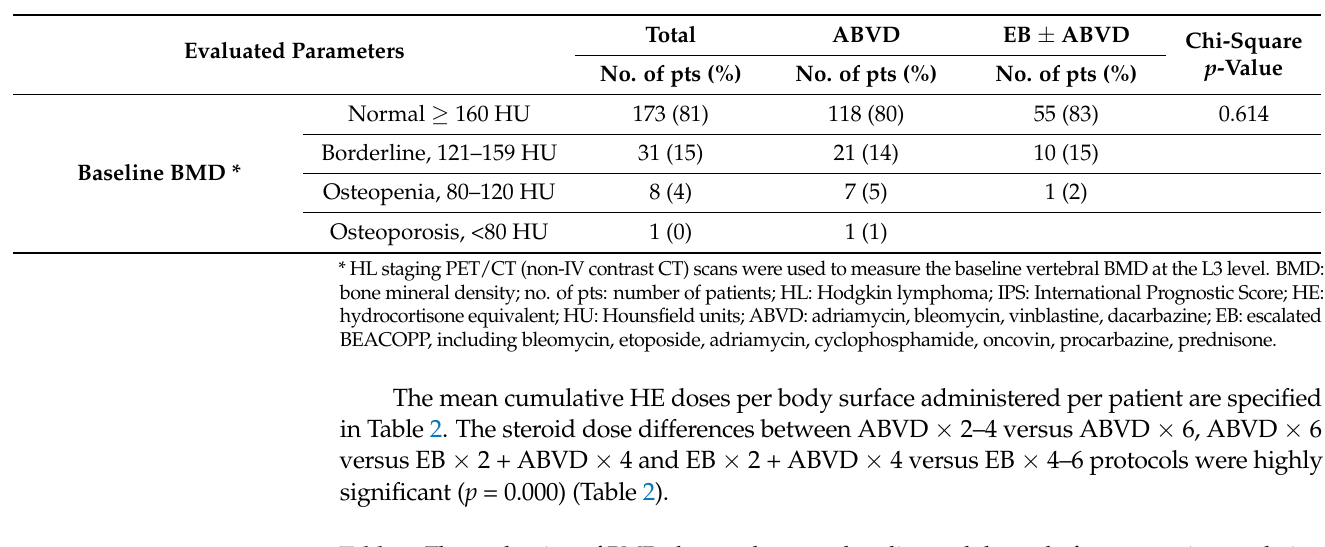
Table 2. The evaluation of BMD changes between baseline and the end of treatment in correlation with the treatment protocol and the cumulative steroid dose